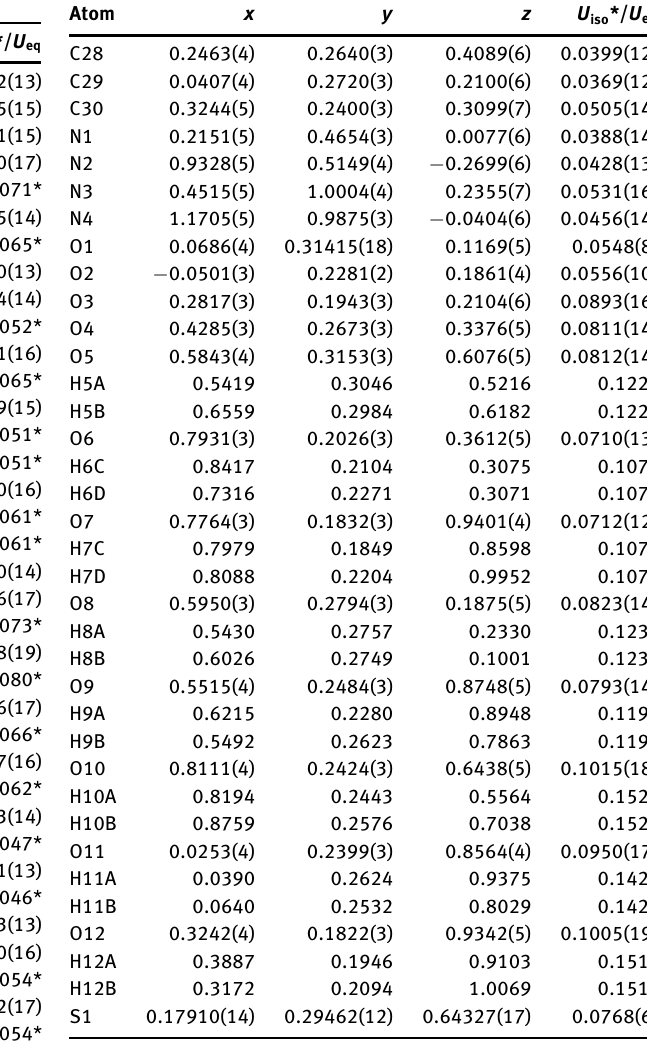
Table 2: Fractional atomic coordinates and isotropic or equivalent isotropic displacement parameters (Å 2